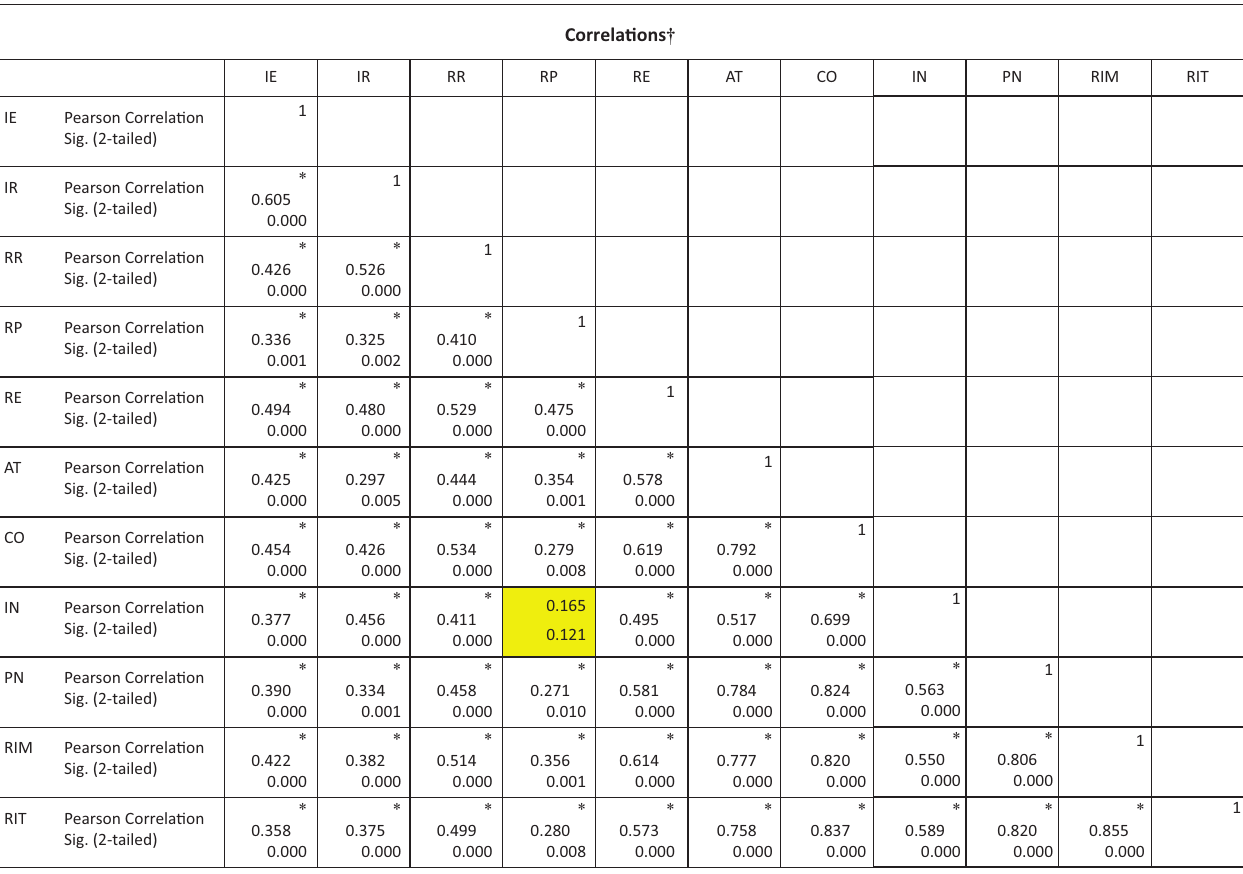
construct indicator. Figure 3 characterises the measurement model for this study.